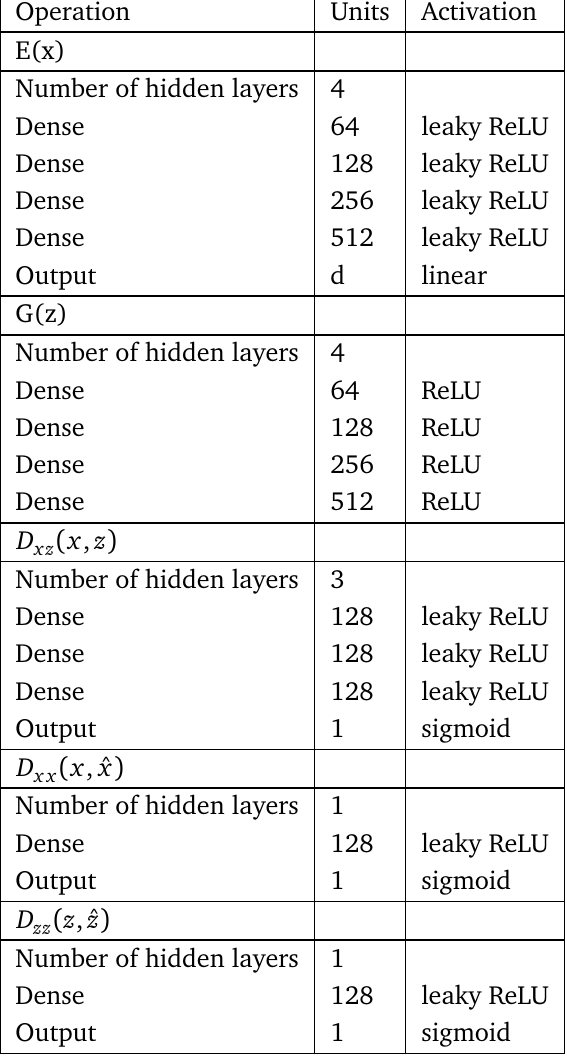
Table 20: ALAD model architecture. Here d is the number of dimensions of the latent